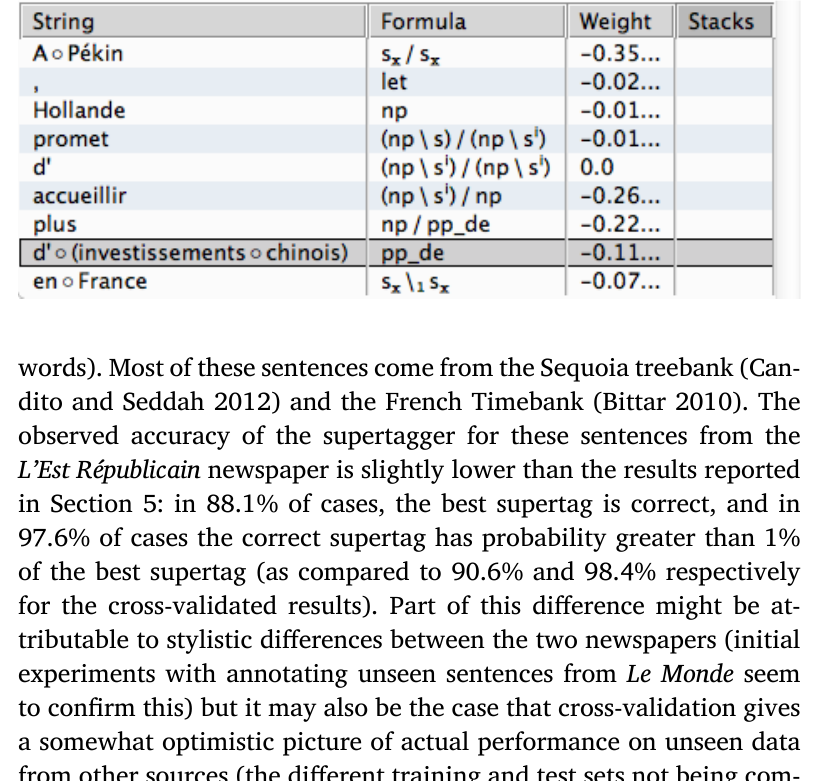
Screenshot of the interactive